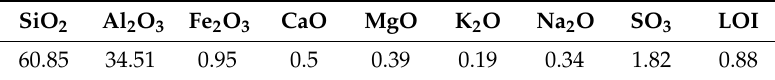
Table 1. Chemical composition of metakaolin (wt